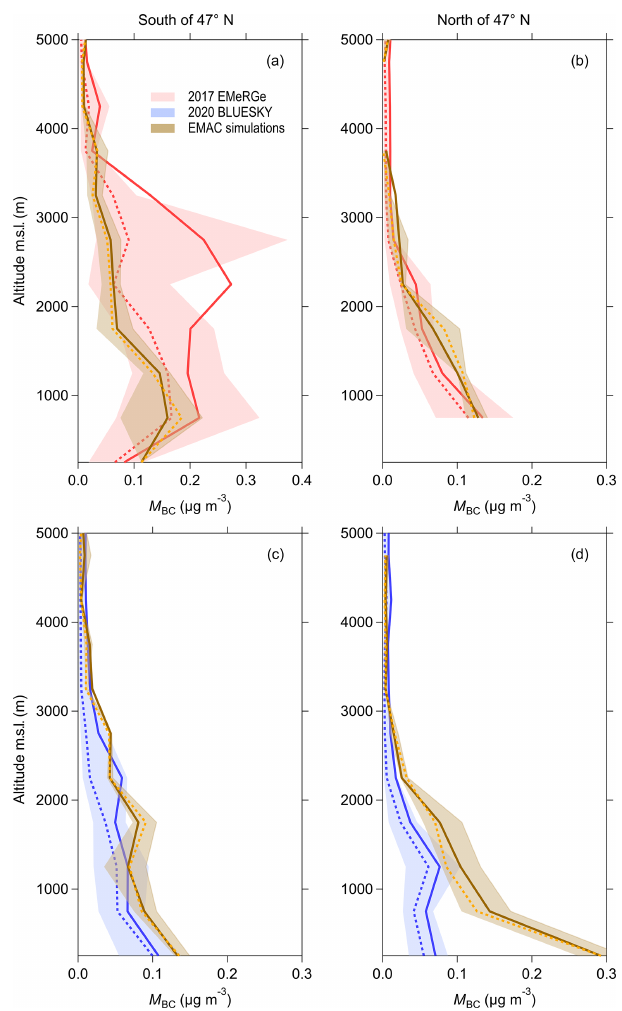
Figure 5. Vertical distribution of M BC north and south of 47 ◦ N. Solid lines represent arithmetic mean values; dashed lines repre- sent median values shading marks the interquartile range. Panels (a) and (b) show data for EMeRGe EU from 2017, (c) and (d) for BLUESKY from 2020. Note that the x axis in (a) ranges between 0 and 0.4µgm − 3